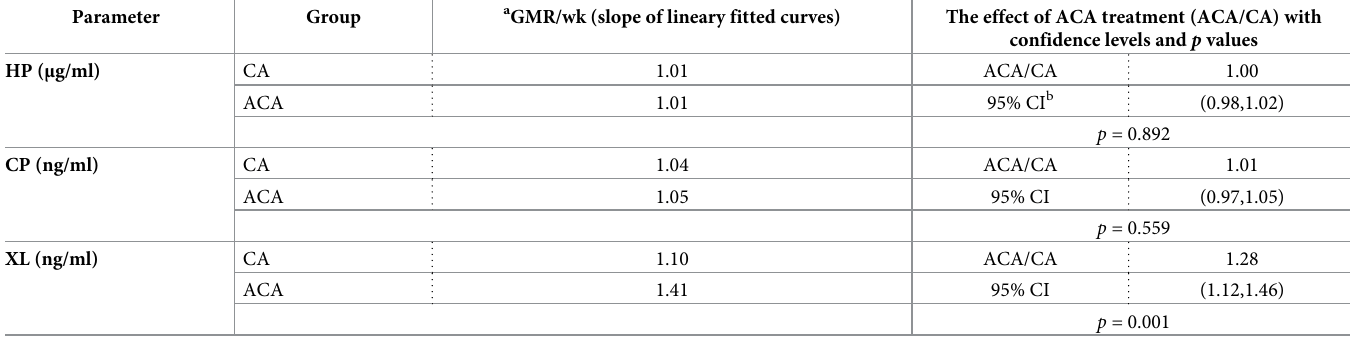
Table 2. A summary of differences in the trajectories of changes in serum hydroxyproline (HP), the C-terminal propeptide of procollagen I (CP), and cross-linked telopeptides (XL) measured between the ACA group and the CA group during the 8-week treatment period.